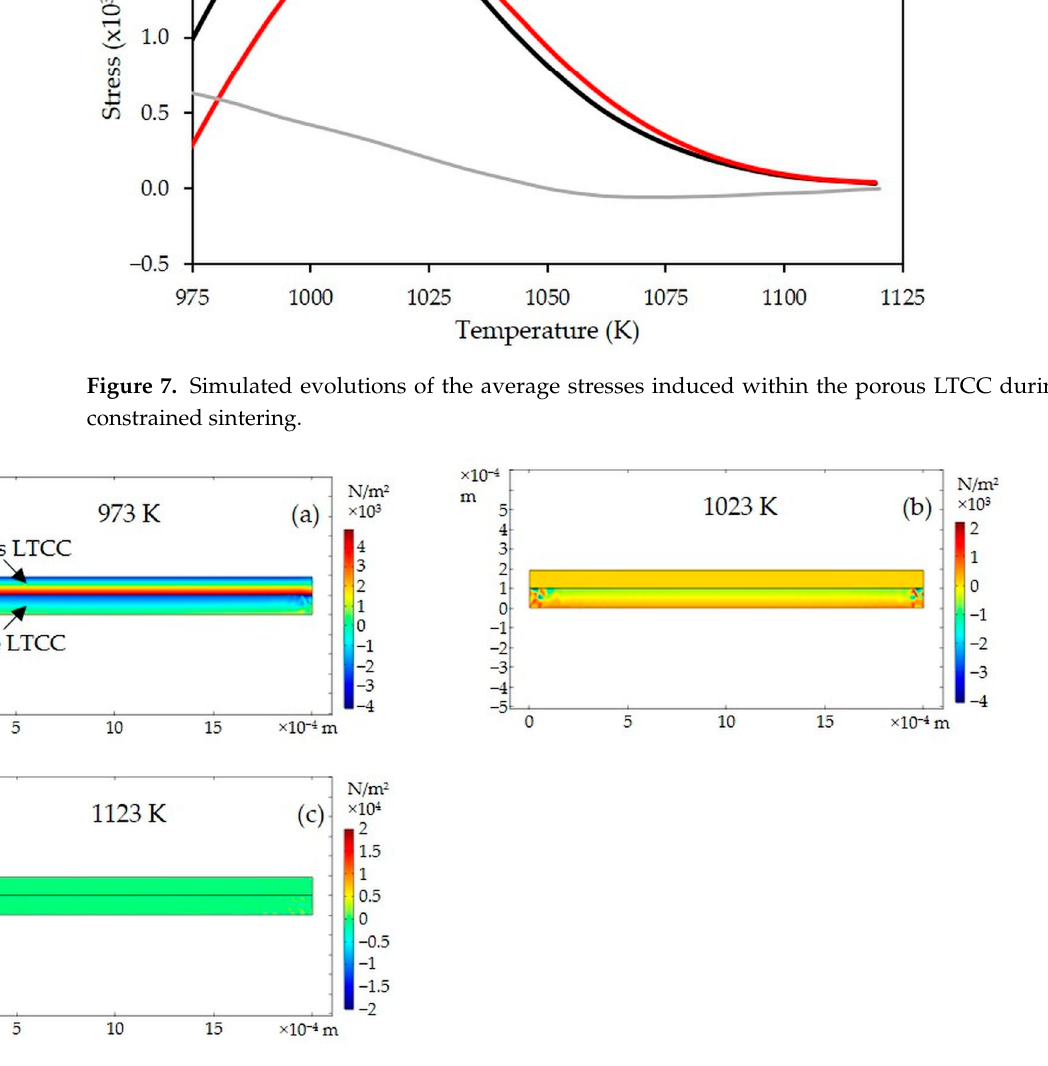
Figure 7. Simulated evolutions of the average stresses induced within the porous LTCC during con- strained sintering.